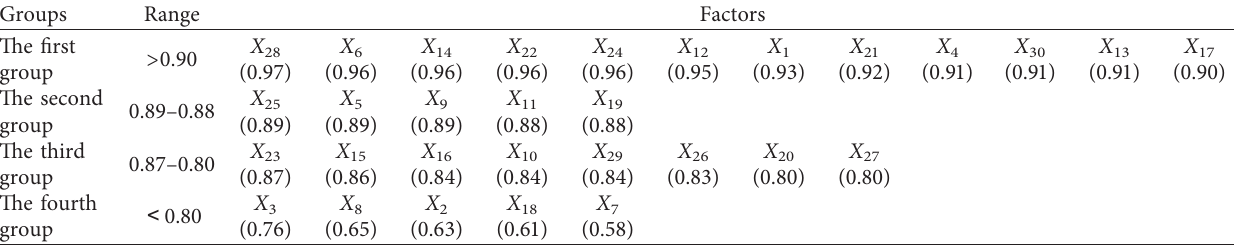
Table 3: Distribution of gray relation degrees of the core competence indicators of Chinese research universities. Groups Range Factors